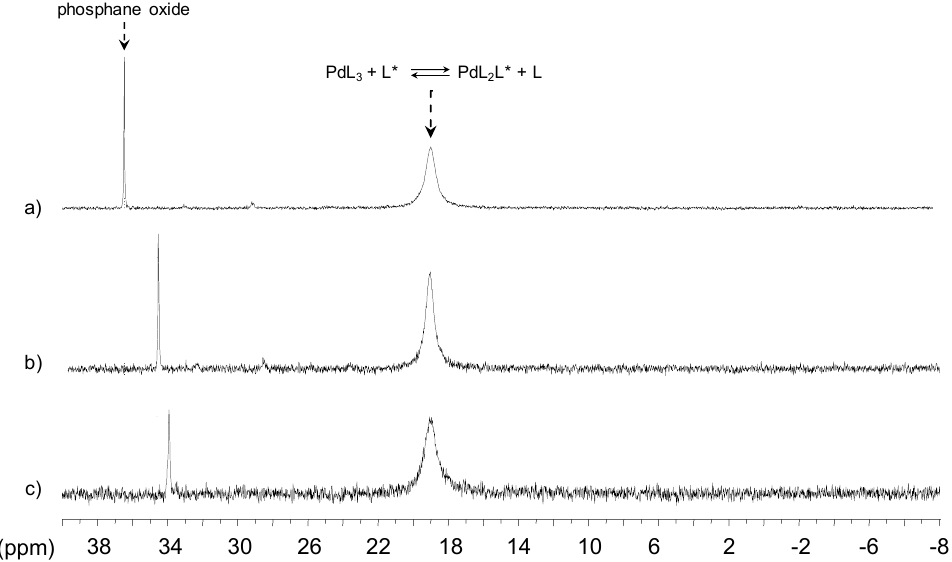
Figure 10. 31 P{ 1 H} NMR spectra of Pd(tris( p -OMe)TPPTS) 3 at ( a ) 25 °C; ( b ) +12 equiv. of RAME- β -CD at 25 °C ( c ) +12 equiv. of RAME- β -CD at 85 °C in D 2 O with a ligand concentration of 66 mM.